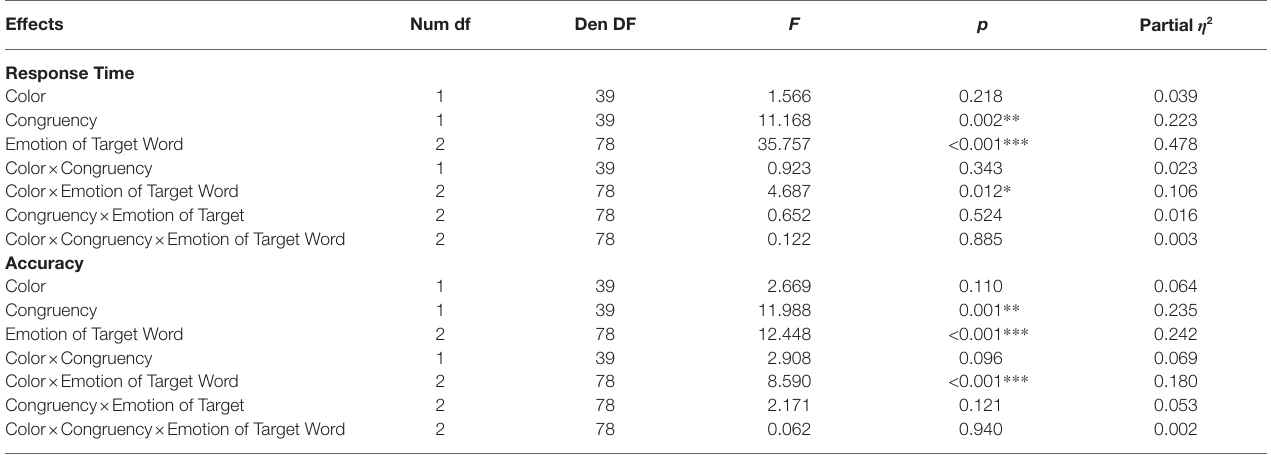
TABLE 3 | Statistical results of repeated measures ANOVAs in experiment 2 (color emostroop task).